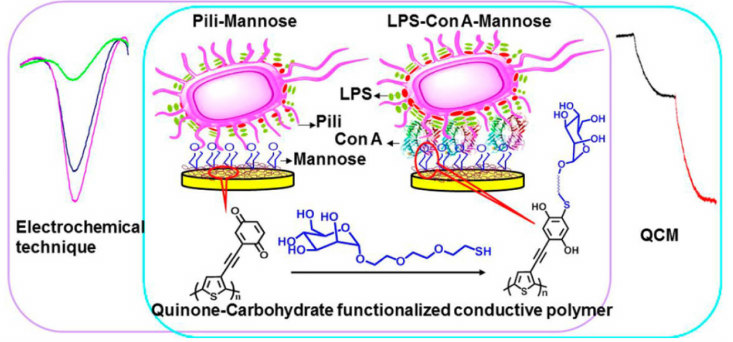
Figure 4. An E. coli sensor based on a quinone-fused poly(thiophene) film-coated electrode and its electrochemical and gravimetric responses. Reprinted with permission from Analytical